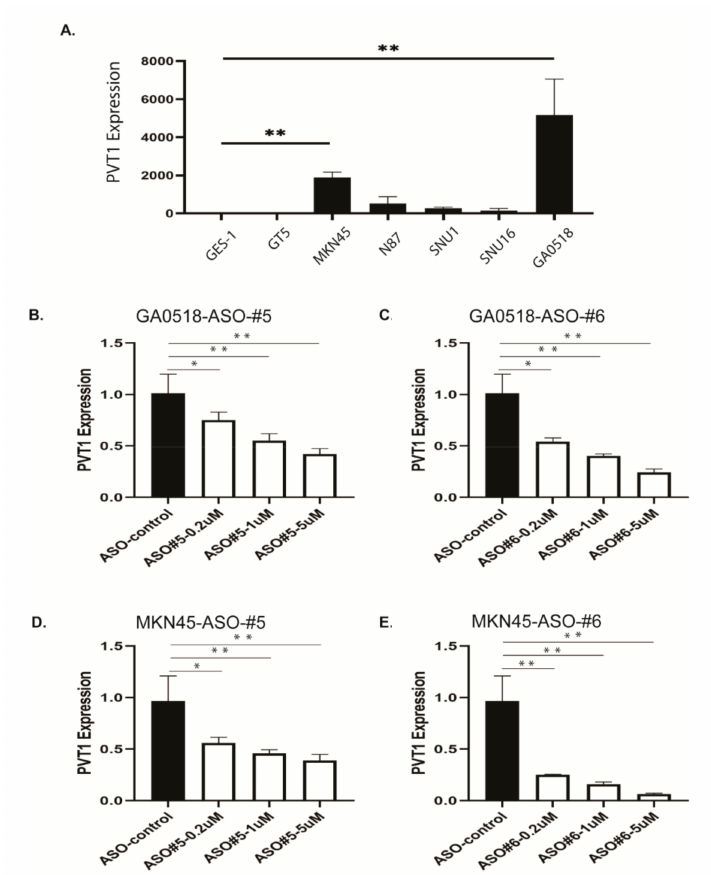
Figure 3. PVT1 expression level was reduced in ASO-treated GAC cells and ascites cells. ( A ). PVT1 expression levels in a normal cell line (GES-1), GAC cell lines (GT5, MKN45, N87, Snu-1, and Snu-16) and patient-derived ascites cells (GA0518) were determined by qPCR. ( B , C ). PVT1 expression levels were analyzed by qPCR in ASO-treated GA0518 cells. PVT1 expression levels were reduced in a dose-dependent manner by ASO#5( p ctrl vs.0.2 = 0.047) ( B ) and ASO#6( p ctrl vs.0.2 = 0.0124) ( C ), ( D , E ). PVT1 expression levels were analyzed by qPCR in ASO-treated MKN45 cells. PVT1 expression levels were reduced in a dose-dependent manner by ASO#5( p ctrl vs.0.2 = 0.046) ( D ) and ASO#6( p ctrl vs.0.2 = 0.007) ( E ). * p < 0.5; ** p <